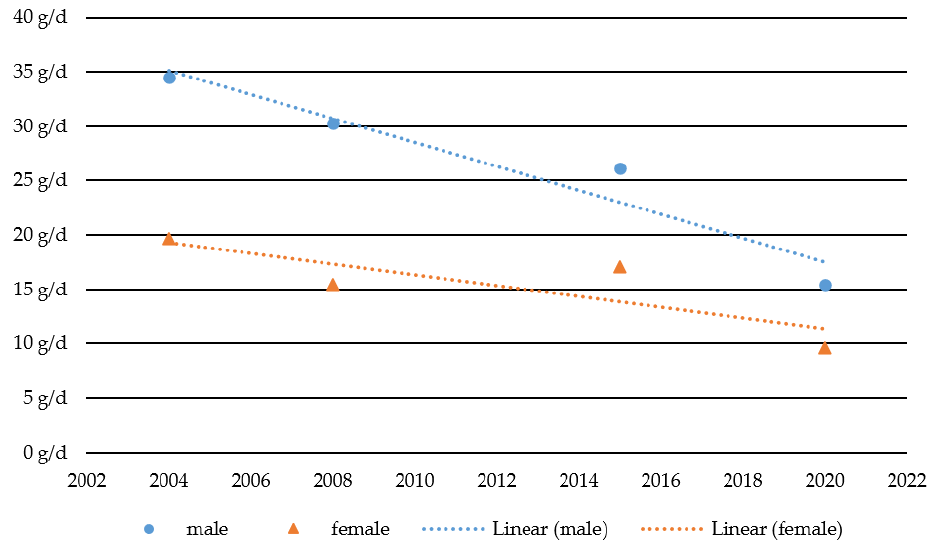
Figure 1. Change in alcohol per capita consumption for male and female adolescents and young adults between 2004 and 2020. Note: g/d = gram/day.